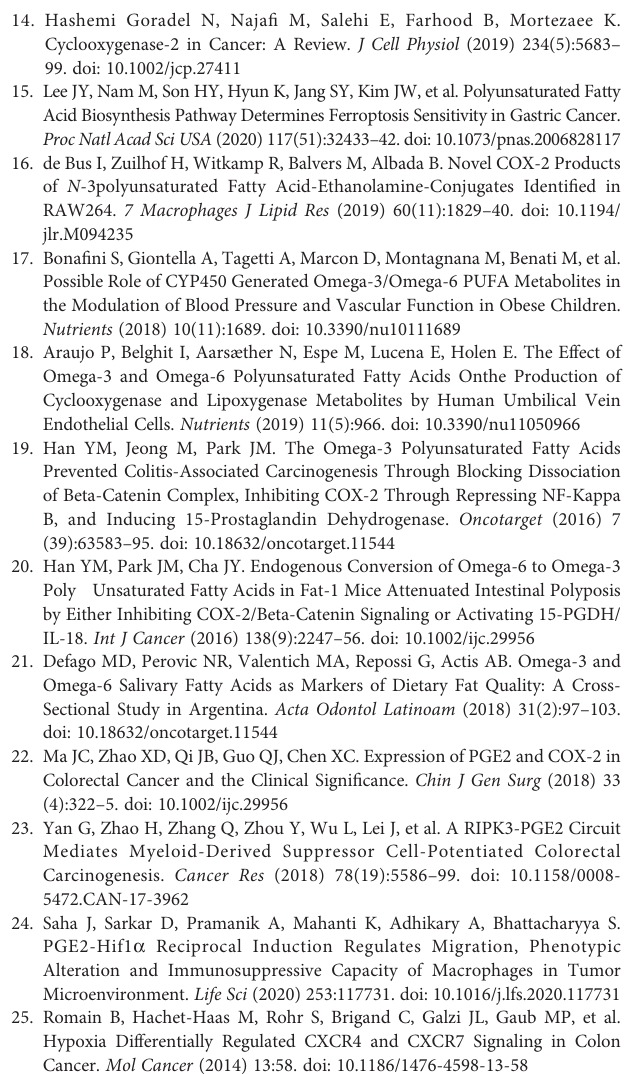
Figure 3 . YC fi nished Figure 4 . JM and YW fi nished Figures 5 , 6